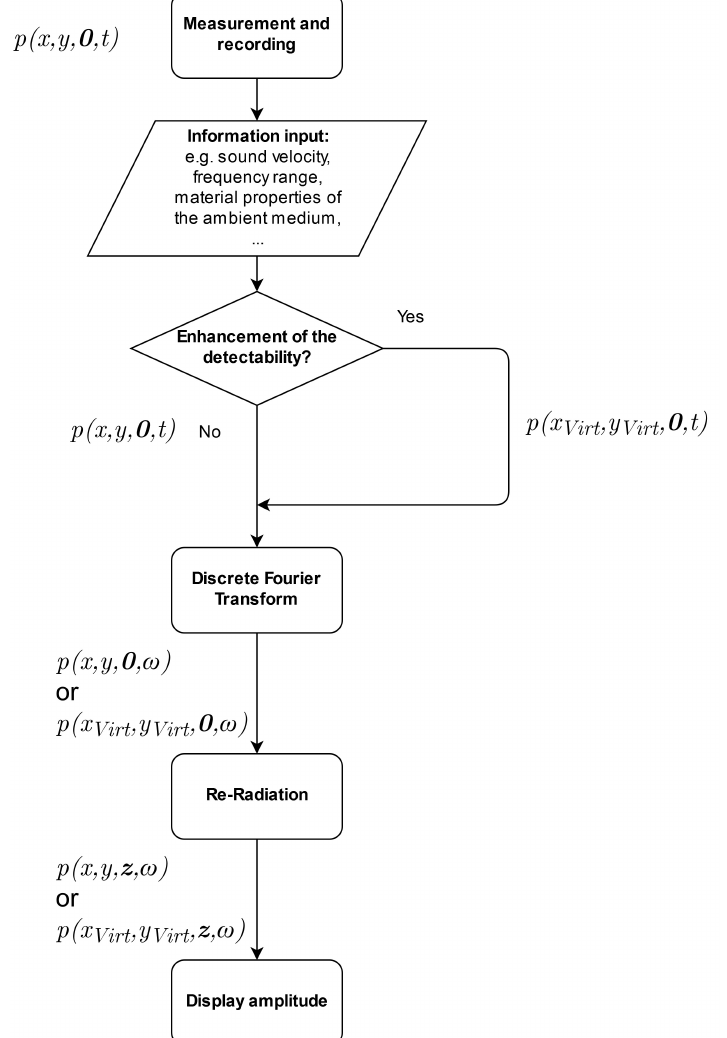
Figure 10. Practical realization and implementation of the re-radiation method with the increase of the